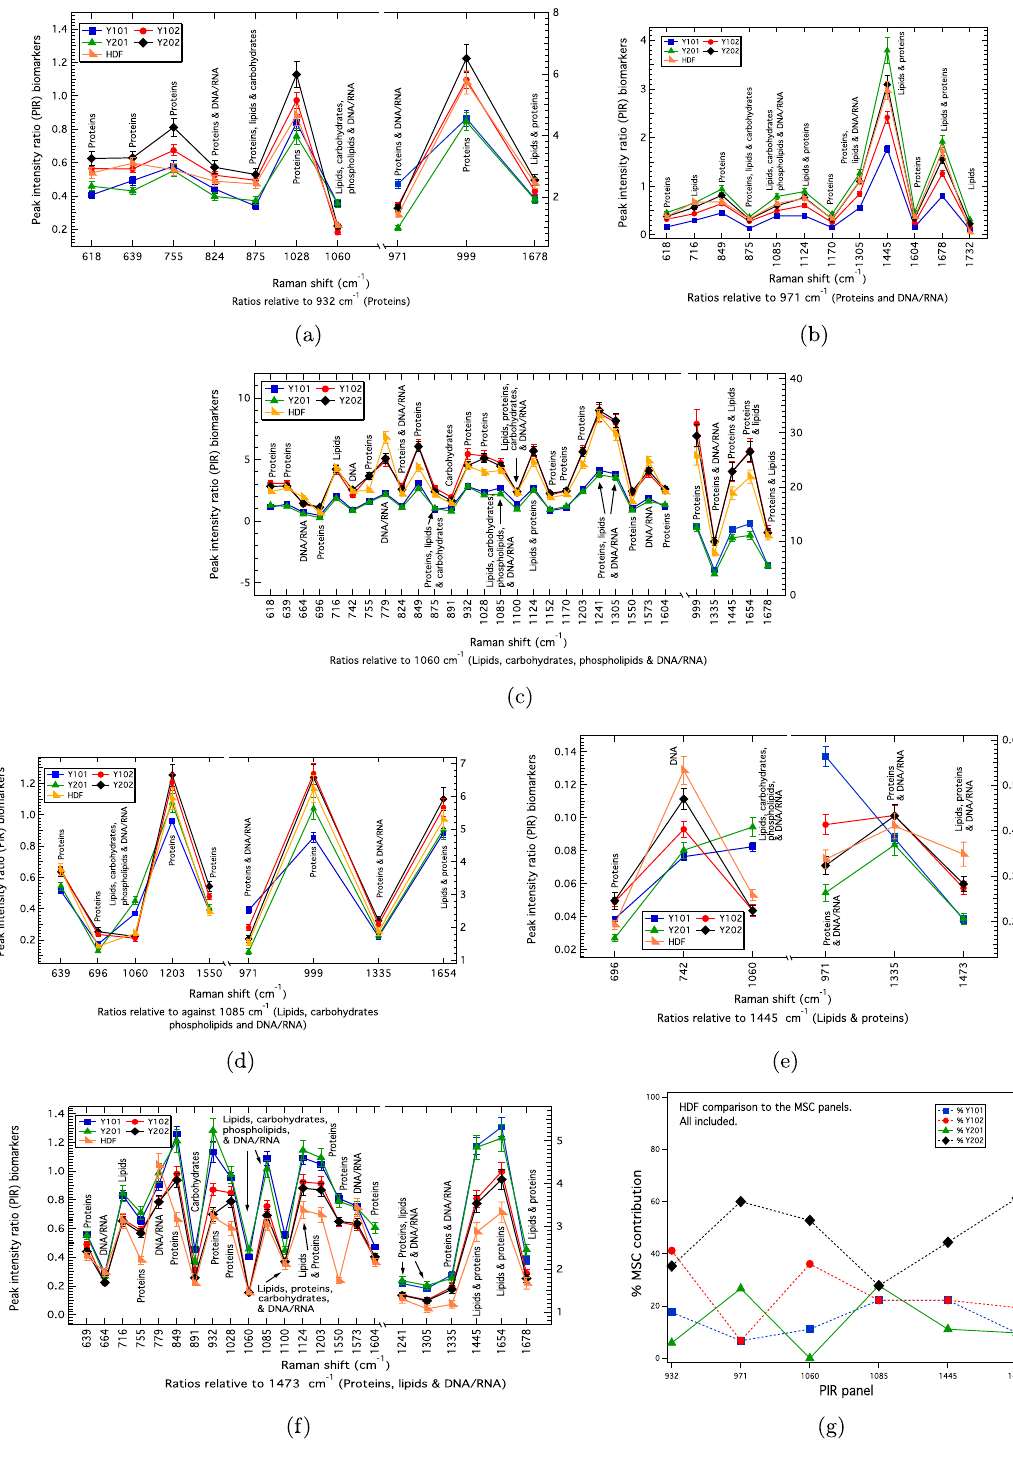
Figure 4. ( a )–( f ) PIRs comparing the HDFs against the hTERT MSCs. The uncertainties correspond to the − 1 propagated standard error of the mean. For the 971 cm panel, which stratifies cell-type, the HDFs are most closely KNN-matched at 60% to Y202 ( b , g ). Under standard culturing conditions, HDFs are expected to be differentiation incompetent 21 , which is indicated here by the close (72%) Y102/Y202 match shown in ( g ) assessed across all PIR panels. The relative differences in Y101/Y201 and Y102/202 matches makes the HDFs phenotypically-distinct (Table